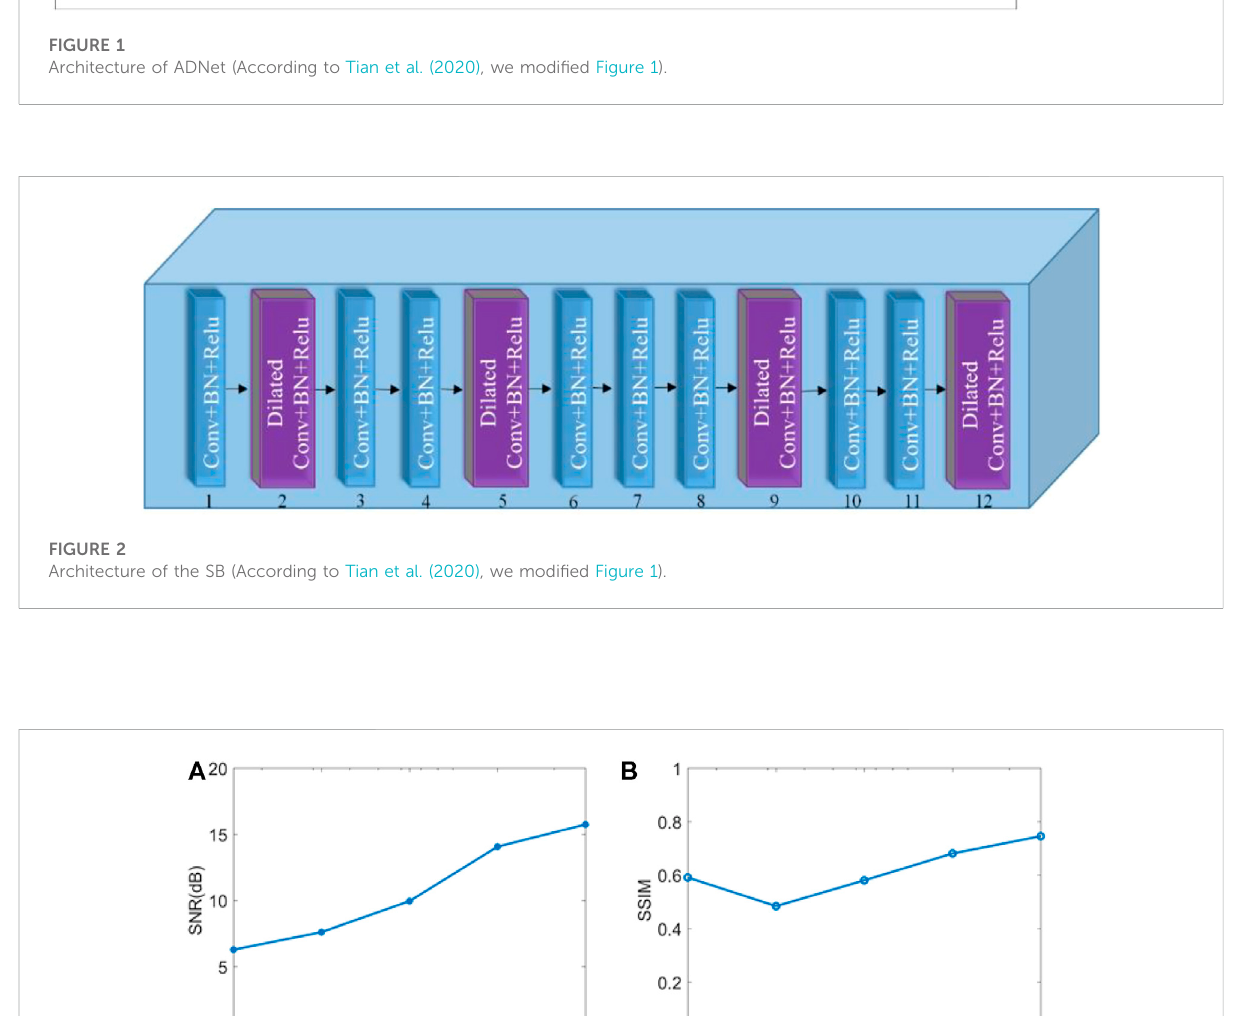
Frontiers in Earth